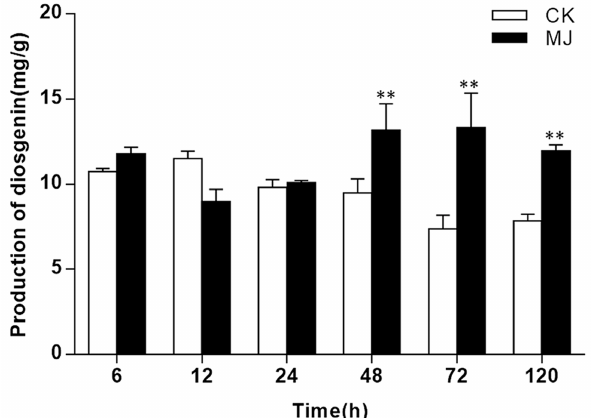
Figure 1. Comparison of diosgenin content between the MeJA-treated and control T. foenum-graecum seedlings under different time points. Error bars indicate ± SD of three biological replicates and tested by paired Student’s t test. The mark “**” indicate very significant difference ( p < 0.01) relative to the corresponding controls at each time point. CK: the 24 h control samples. MJ: the 24 h MeJA-treated samples.